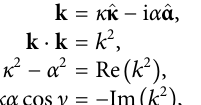
Frontiers in Earth Science |